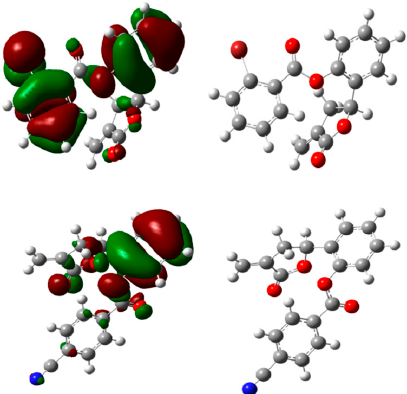
Figure 3. Experimental pIC 50 vs. predicted pIC 50 .